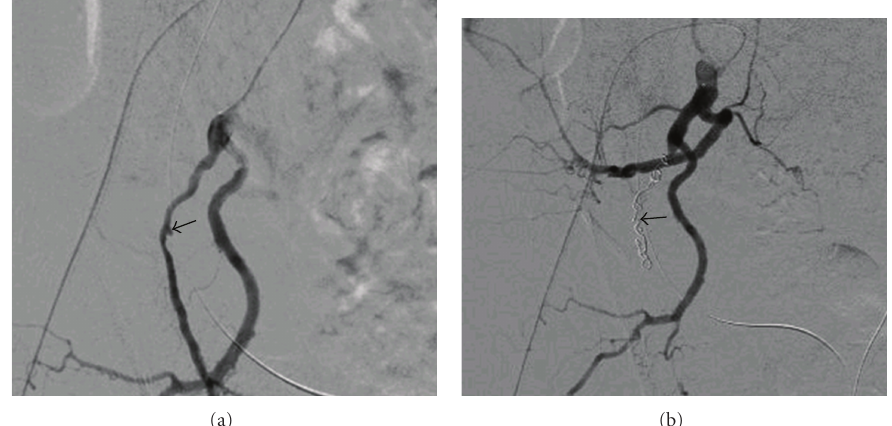
Figure 3: (a) A pseudoaneurysm (arrow) detected at the time of the second angiography. (b) Endovascular coils (arrow) inserted into the right internal pudendal